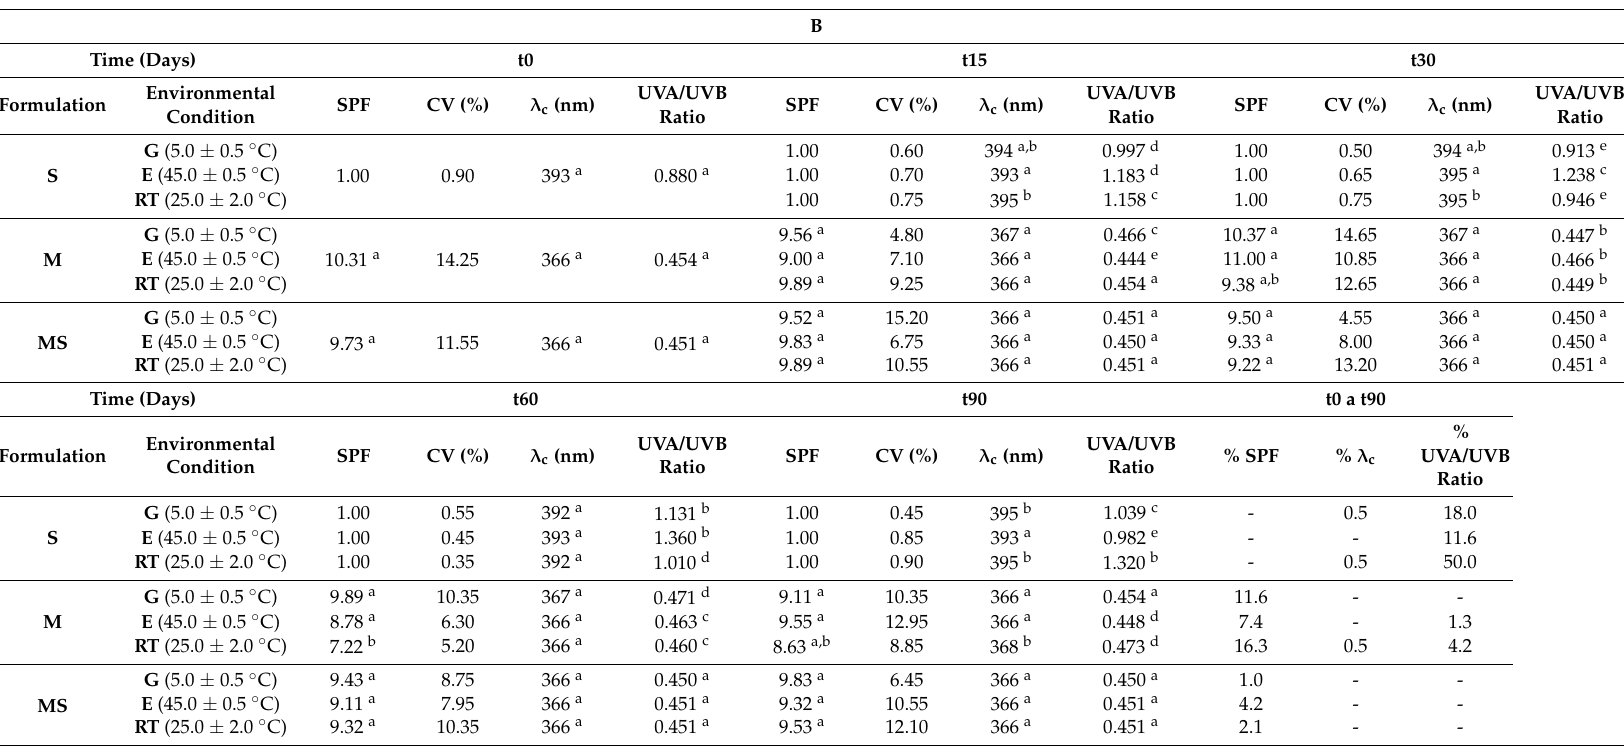
Table 4. Analysis of photoprotective efficacy as assessed by Normal Stability Test of formulations developed with cream base B with addition of chemical and physical filters ( M ), rutin succinate ( S ) or rutin succinate + chemical and physical filters ( MS ).